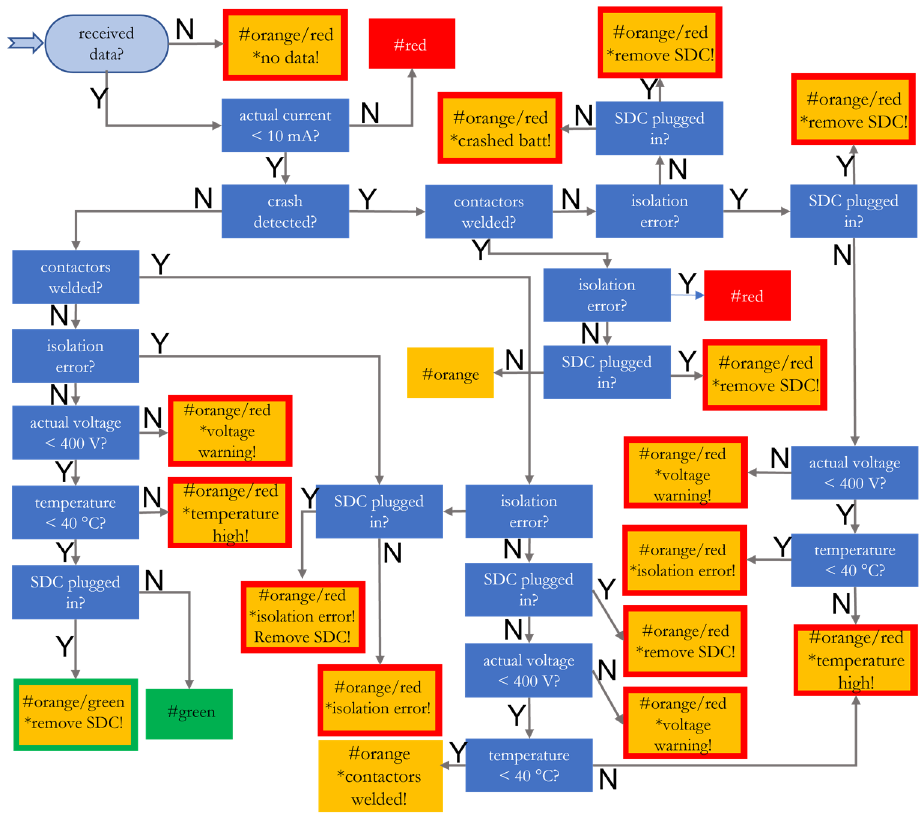
Figure 9. Implementation of the evaluation algorithm for an example battery in the case of transport preparation: every decision block (blue) consists of an available CAN-signal and an evaluation criterion for its physical value. Depending on the values, the tree is followed until a state result (colored blocks) is reached. Some state results include additional information, which is displayed in the ”BatteryCheck” app (marked with ‘*’). The symbol “#” in front of the state results is used by the application to identify a node as a termination node (=state result) to stop the processing and display the result.